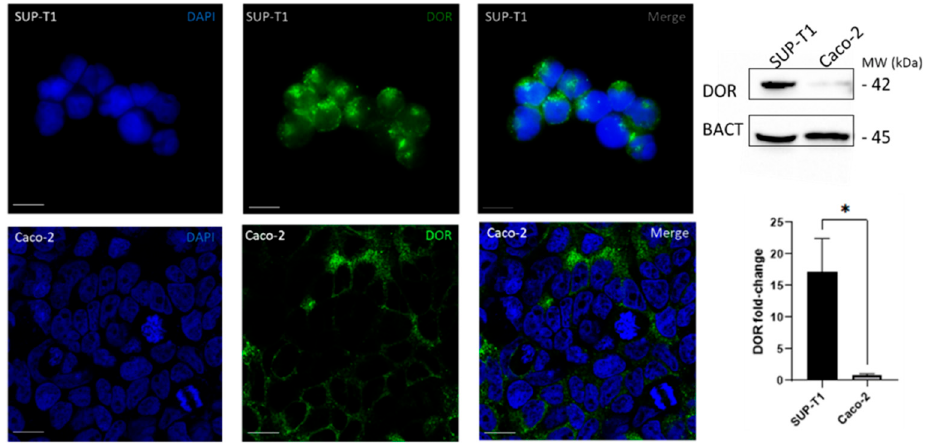
Figure 1. Analysis of DOR expression levels. On the left, immunofluorescence of DOR (green) in SUP-T1 and Caco-2 cell lines. Nuclei were stained in DAPI. Scale bars (10 μ m) are reported. Images were visualized through a LEICA DM6 B fluorescent microscope with ORCA-Flash 4.0 V3 system (60X). On the right, immunoblotting and relative densitometric analysis of DOR in SUP-T1 and Caco-2 cells. DOR expression was normalized to β -actin (BACT) levels. Normalized values are shown on the Y -axis as arbitrary units. Molecular weights (MW) and SEM bars are reported. Asterisk indicates p < 0.05 (ANOVA One-Way), compared with SUP-T1 cells. The experiments were performed on three independent biological replicas.